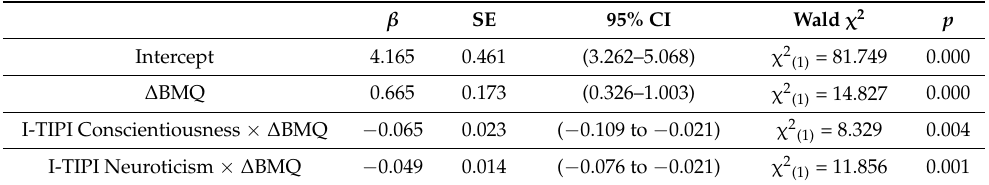
Table 3. Results of the model